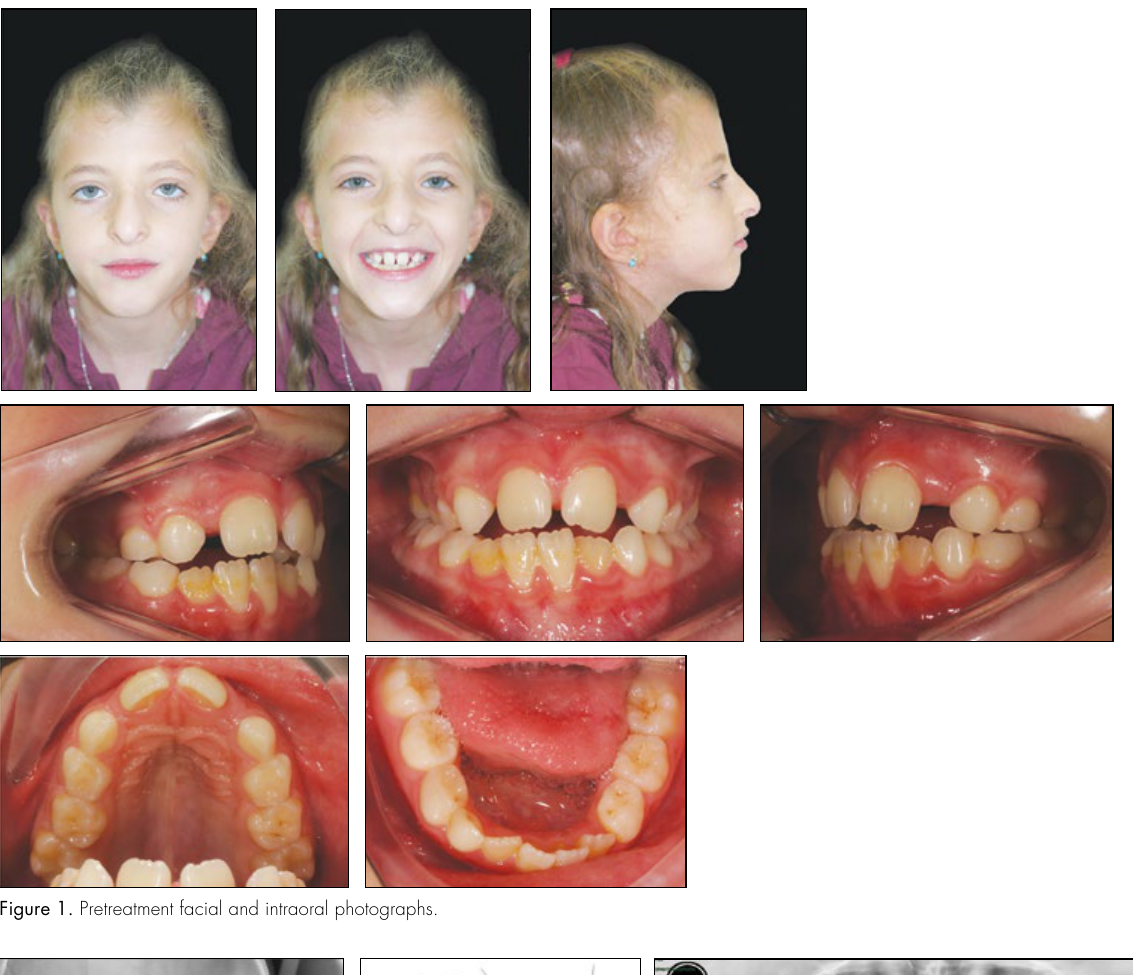
Figure 1. Pretreatment facial and intraoral photographs.